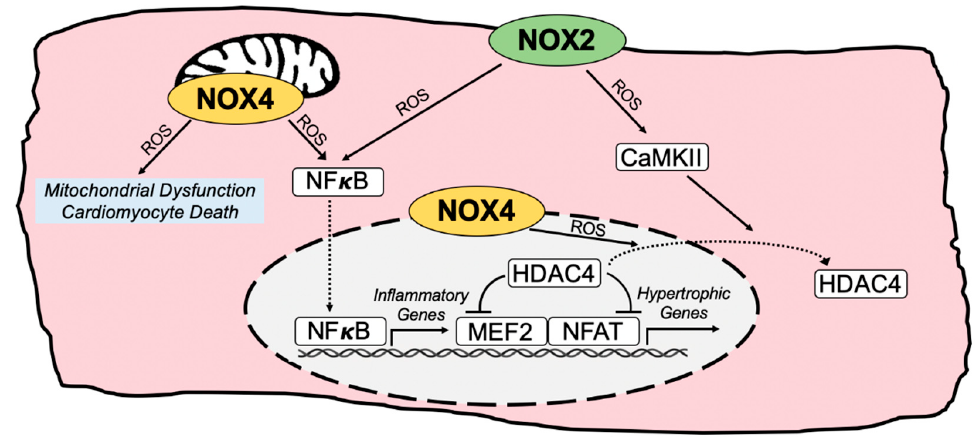
Figure 2. Pathogenic NOX-regulated redox signaling circuitry in cardiac myocytes. Depiction of major pathological redox-sensitive signaling effectors and pathways regulated by NOX2 and NOX4 in cardiomyocytes. CaMKII , calcium/calmodulin-dependent protein kinase II; HDAC4 , histone deacetylase 4; MEF2 , myocyte enhancer factor 2; NFAT , nuclear factor of activated T cells; NF κ B , nuclear factor kappa B; ROS , reactive oxygen species.